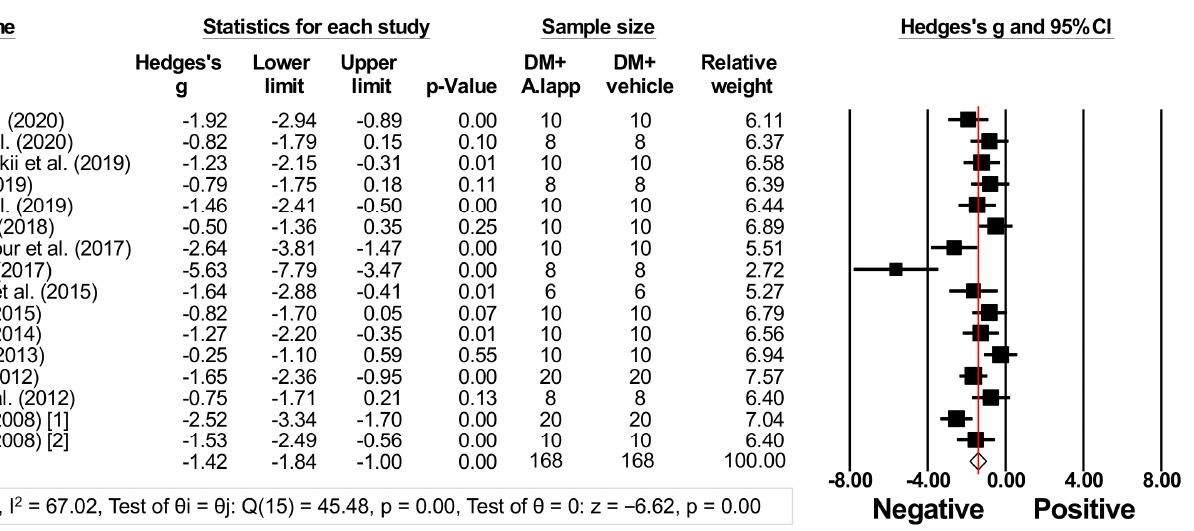
Figure 2. Meta-analysis of Hedges’ g of BG levels in DM rodents administered with either A. lappa extracts and arctigenin-related compounds or vehicles. A red line indicates the pooled effect size. CI, confidence interval.